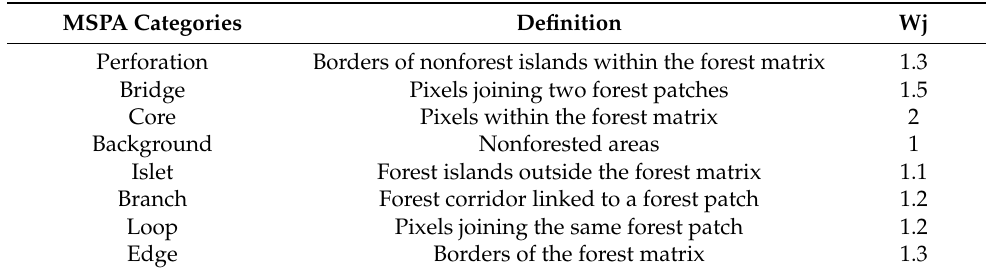
Table 3. Weights for the morphological spatial pattern analysis (MSPA) classes (Wj), taking into account the assessment of habitat fragmentation [9].